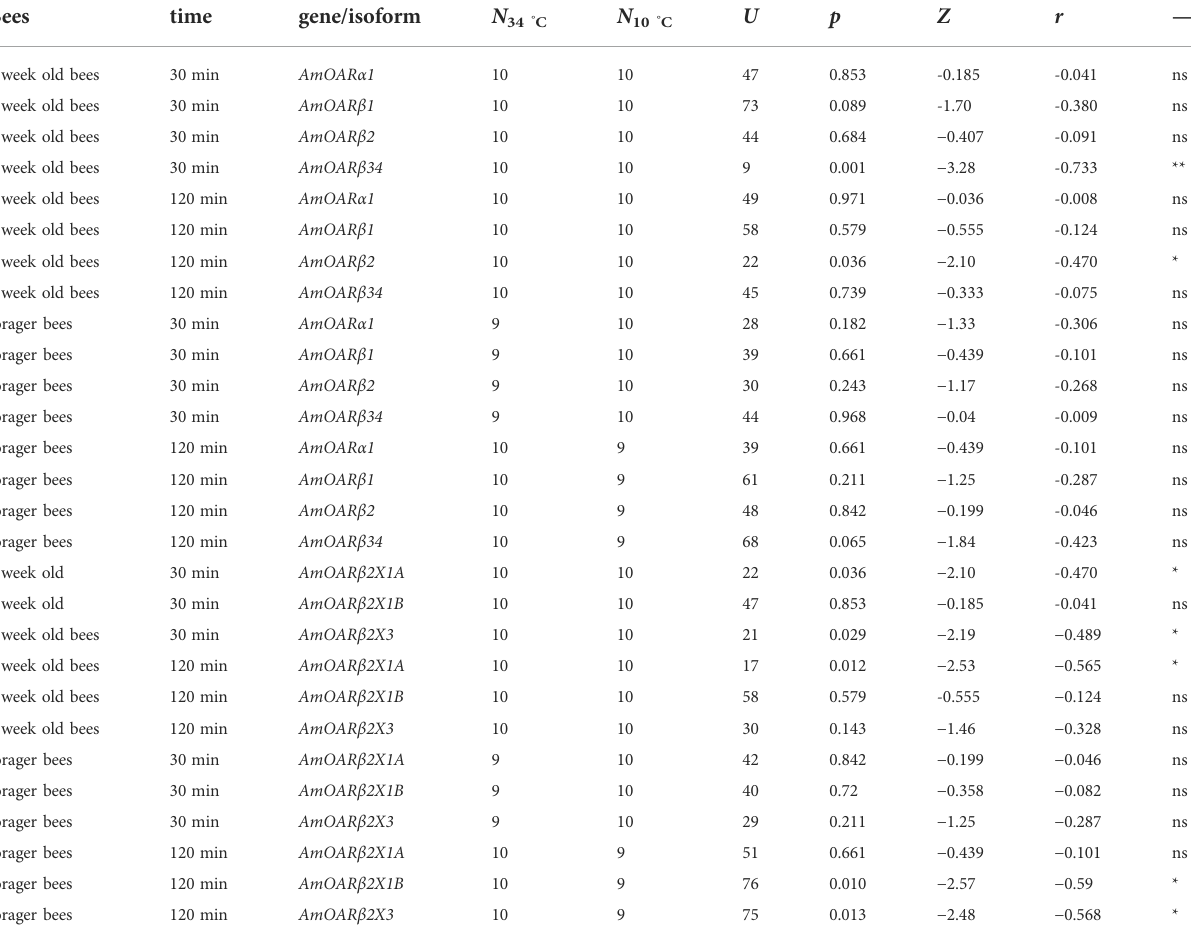
TABLE 2 Results of the statistical analysis (Mann-Whitney U test) of octopamine receptor gene expression in workerbee fl ight muscles under cold stress (34 ° C vs 10 ° C). For visualization please see Figures 2, 3. * = p < 0.05, ** = p < 0.01, ns = p ≥ 0.05. Bees time gene/isoform